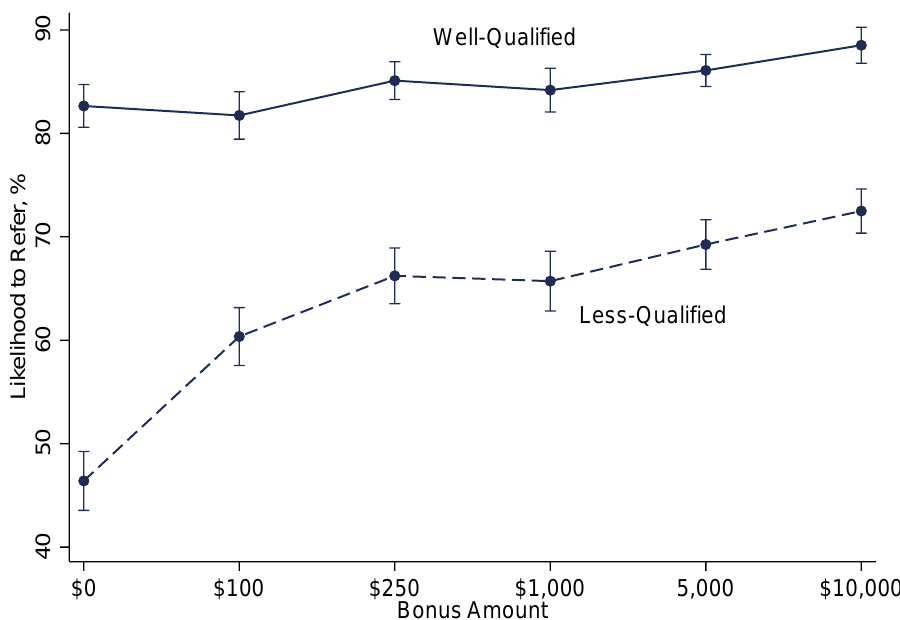
Figure 1: Less-qualified candidates referred more given (higher) bonuses (%